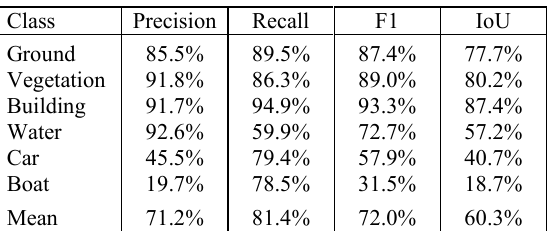
SUM benchmark dataset. Per - class results of oblique image segmentation.